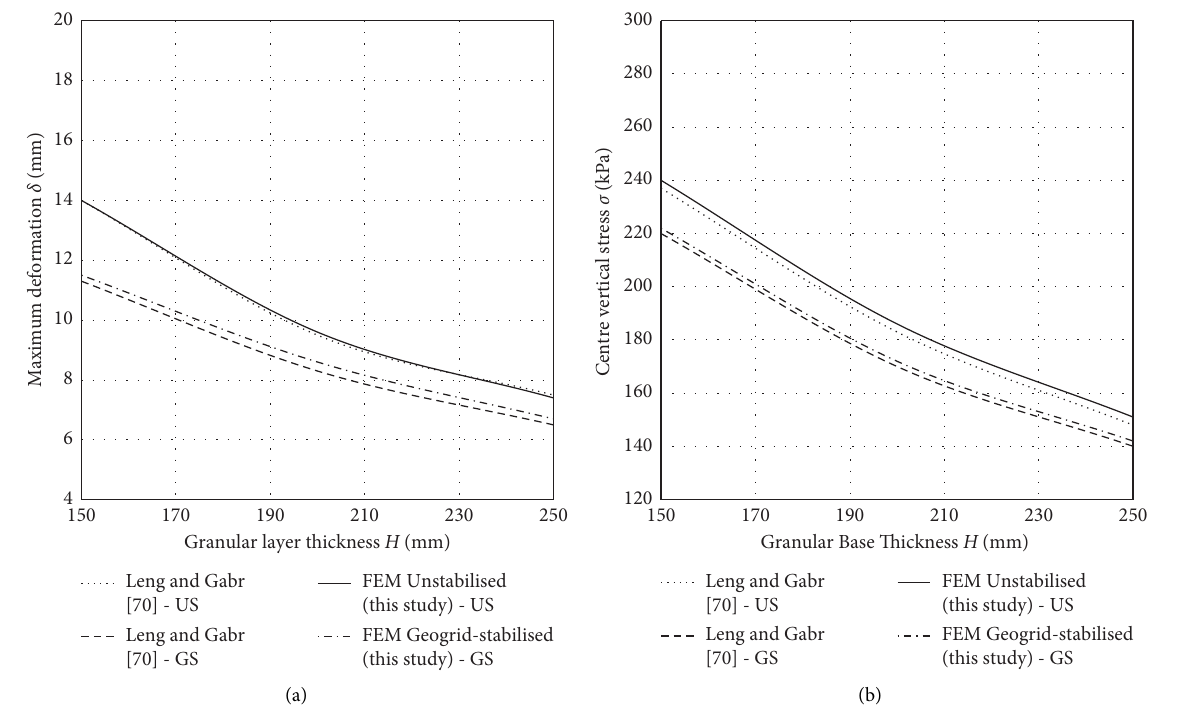
Figure 13: Surface deformations for unstabilised and geogrid-stabilised pavement structures (US: unstabilised and GS: